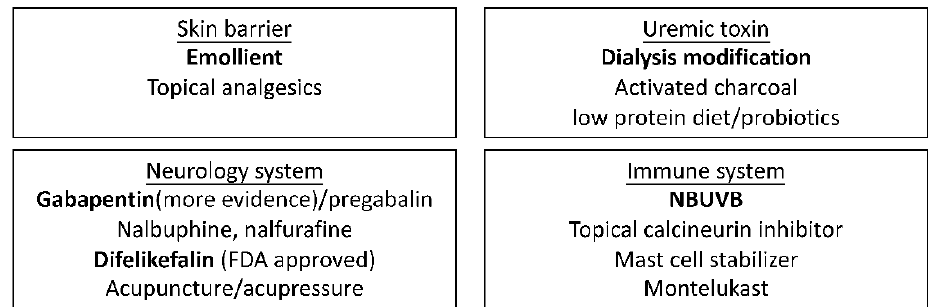
Figure 1. Proposed diagnosis and treatment algorithm of uremic pruritus.